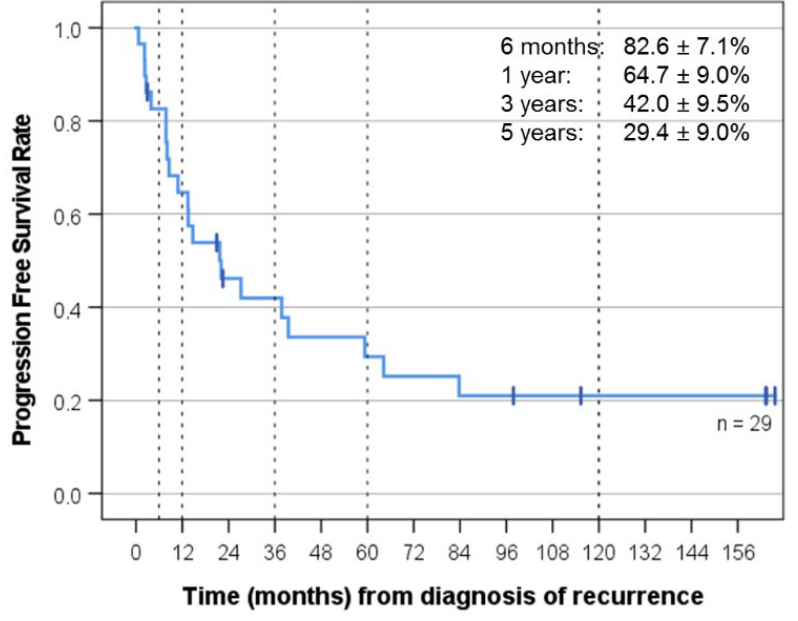
Figure 3. Progression-free survival (PFS) for all 29 patients from time of diagnosis of recurrence that prompted MEMMAT-like therapy. Median PFS was 22.1 months (KI 6-39).